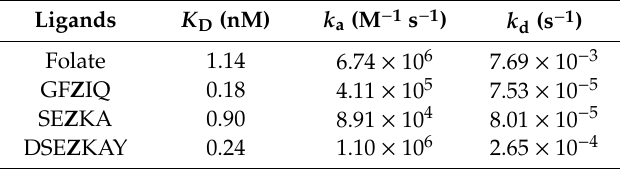
Table 2. BLI results for the binding a ffi nity of folate and folate-peptide